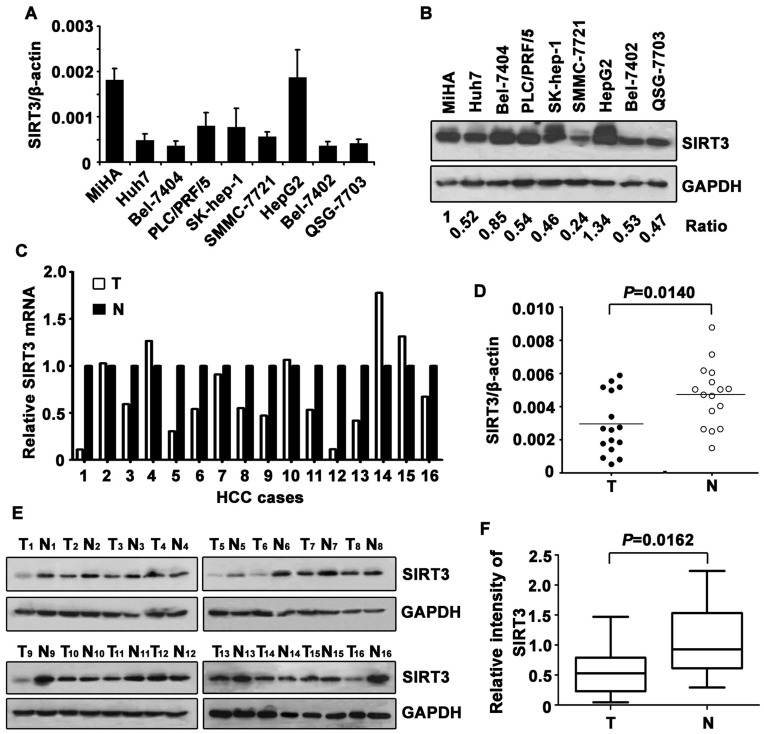
Expression of SIRT3 in HCC cell lines and tissue samples. A.mRNA level of SIRT3 in immobilized liver cell line (MiHA) and HCC cell lines was determined by qRT-PCR. Three independent experiments were performed. Data are mean ± SD. B. Representative pattern of SIRT3 protein expressed in cell lines was shown. The ratio of SIRT3/GAPDH was indicated as well. C. mRNA level of SIRT3 in HCC and corresponding adjacent liver tissue was determined in 16 patients. Relative SIRT3 mRNA in HCC tissues was presented. D. Wilcoxon matched paired test revealed the significant alteration of SIRT3 mRNA in tissue samples. E. Expression of SIRT3 protein in 16 paired HCC and adjacent normal liver tissues were examined by western blot. F. Relative intensity of PLK4 normalized to GAPDH was calculated.